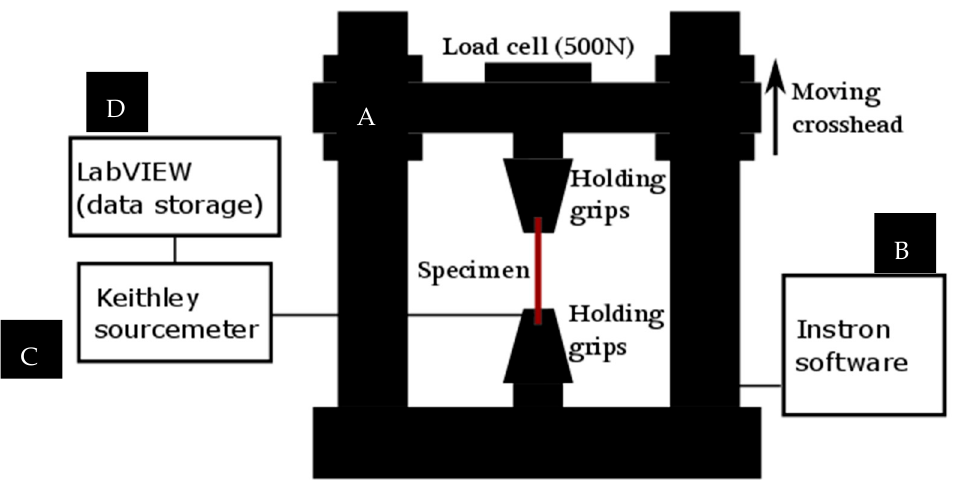
Figure 6. The schematic of the setup for electromechanical assessment. ( A ) The Instron 4411 Universal Testing Machine, ( B ) Instron software on a PC, ( C ) Keithley 2425 SourceMeter, and ( D ) LabVIEW software (version 2014, National Instruments, Austin, TX, USA) on a laptop.